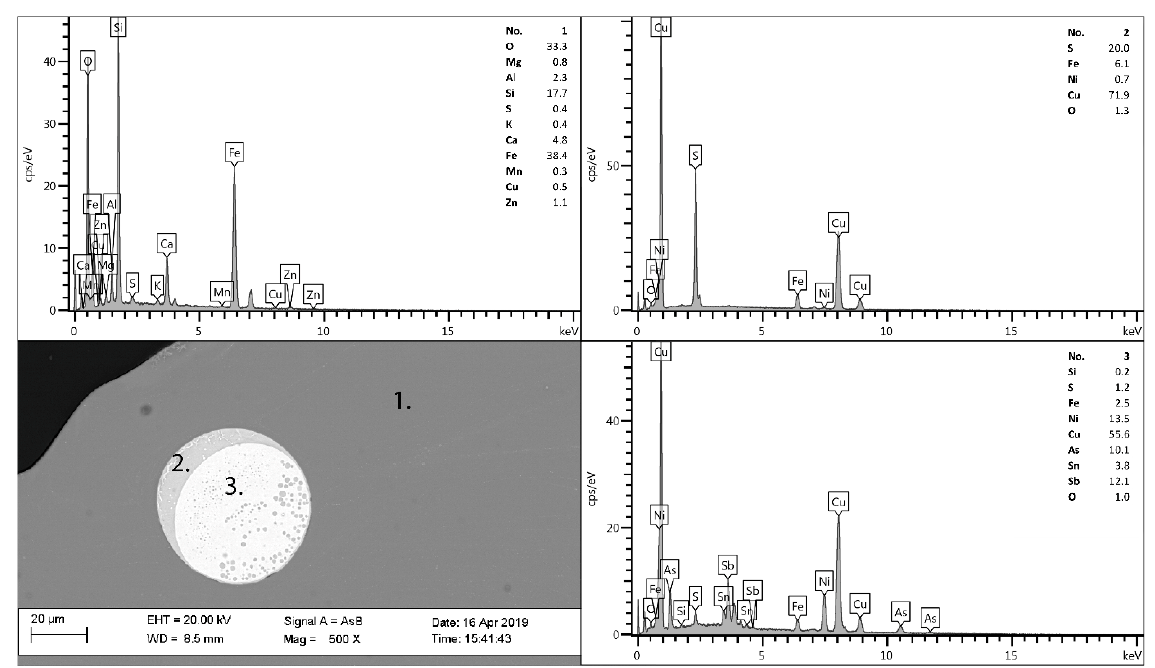
Figure 3. SEM image with EDS point analyses for sample F06, 1—slag matrix, 2—matte, and 3—speiss.